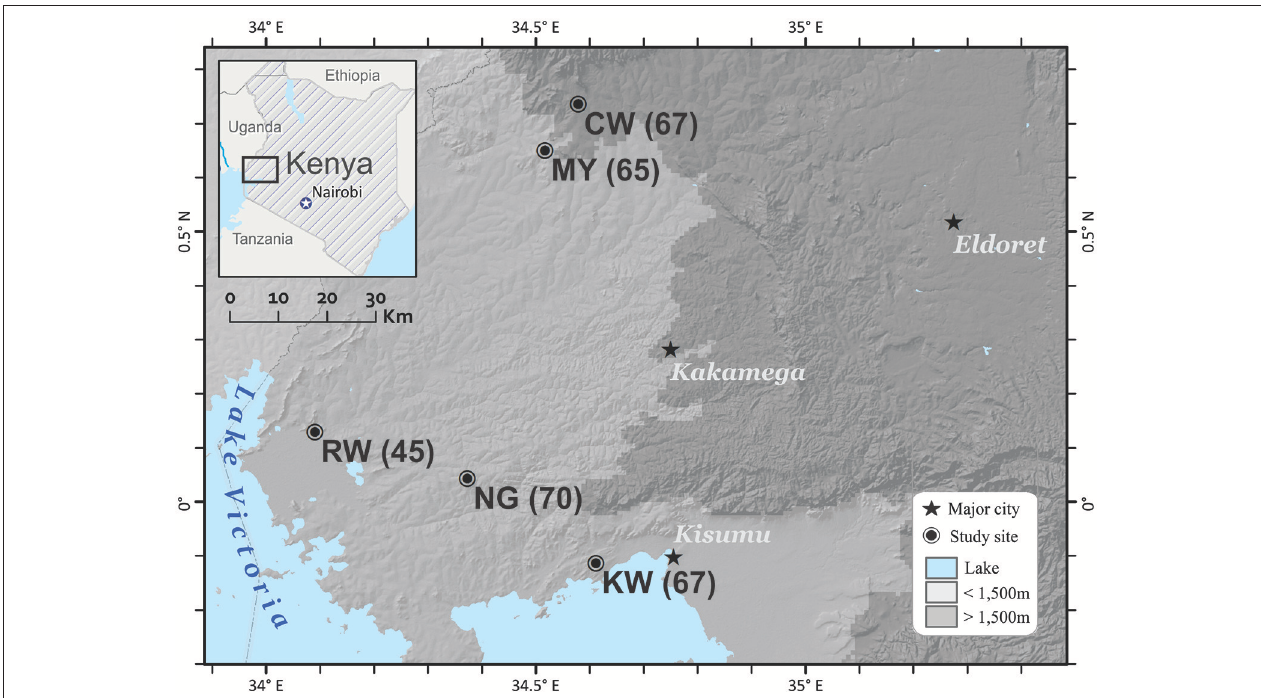
FIGURE 1 | Location of the five field sites in western Kenya. Three of the sites, Kanyawegi (KW), Ngiya (NG), and Rwambua (RW) are below 1,500m elevation and are located within 30km of Lake Victoria. The remaining two sites, Chwele (CW), and Mayanja (MY), are more distant from the lake and above 1,500m in elevation in Western Kenya. Number in parentheses indicates samples size. This figure was generated with ArcGIS Desktop 10.4 (www.esri.com).